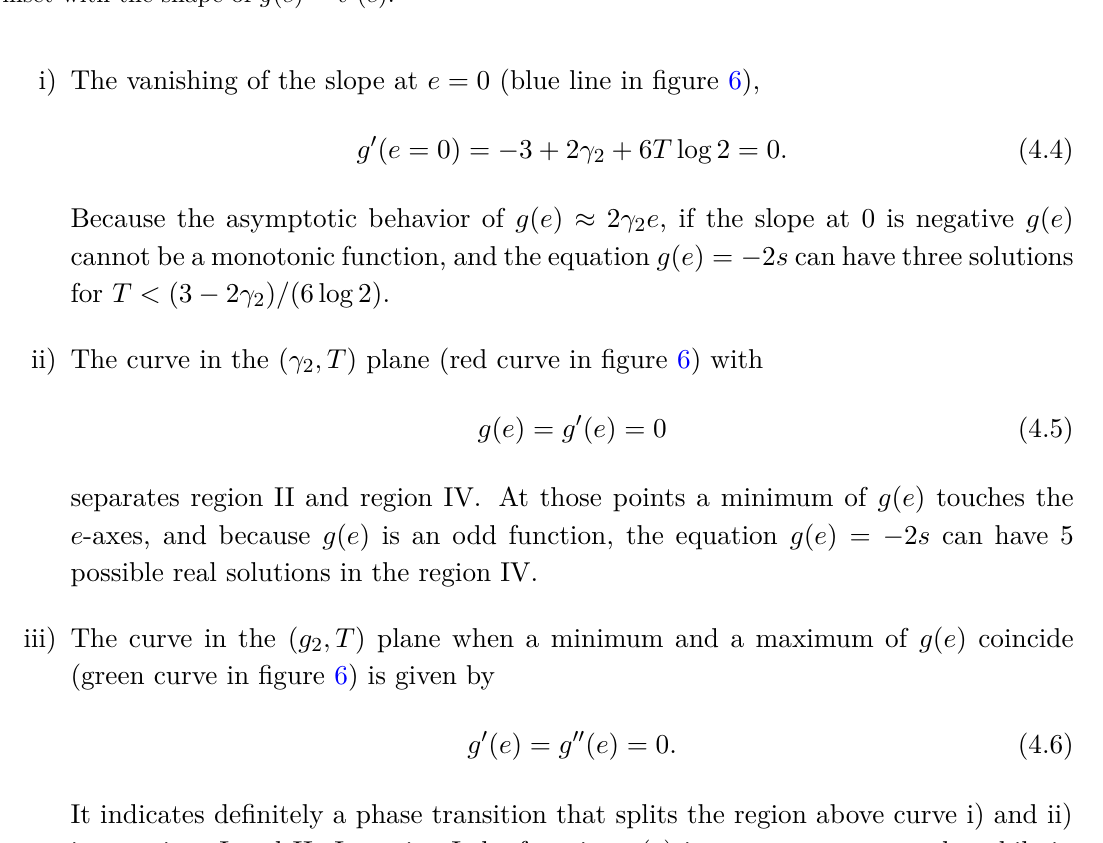
Figure 6 . Phase diagram of g ( e ) . For each region, labeled by Roman numerals, we included an inset with the shape of g ( e ) = v 0 ( e )